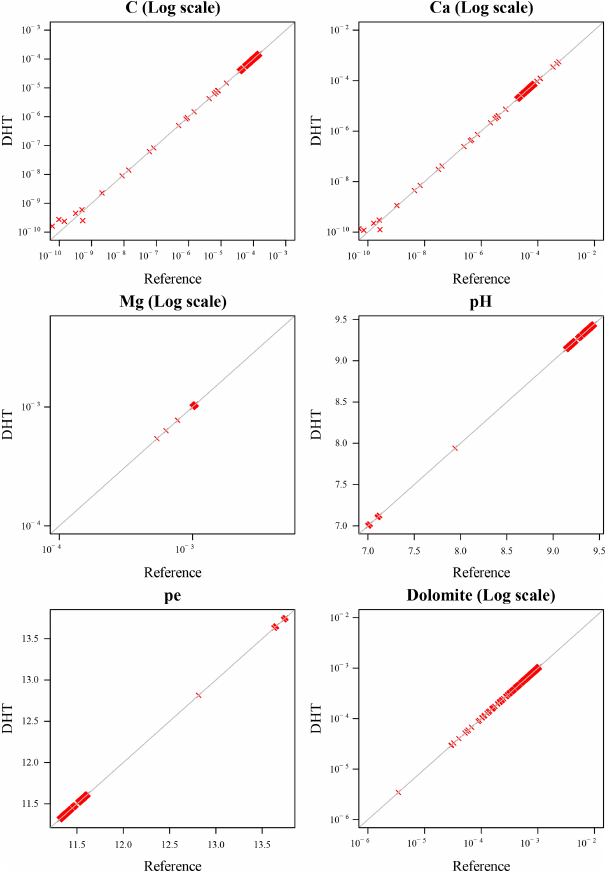
Figure 9. Raw variables, 6_6 digits: scatterplot of DHT and refer- ence variables after 300 iterations. While results of the DHT sim- ulations are accurate enough, discrepancies are evident for small values of the